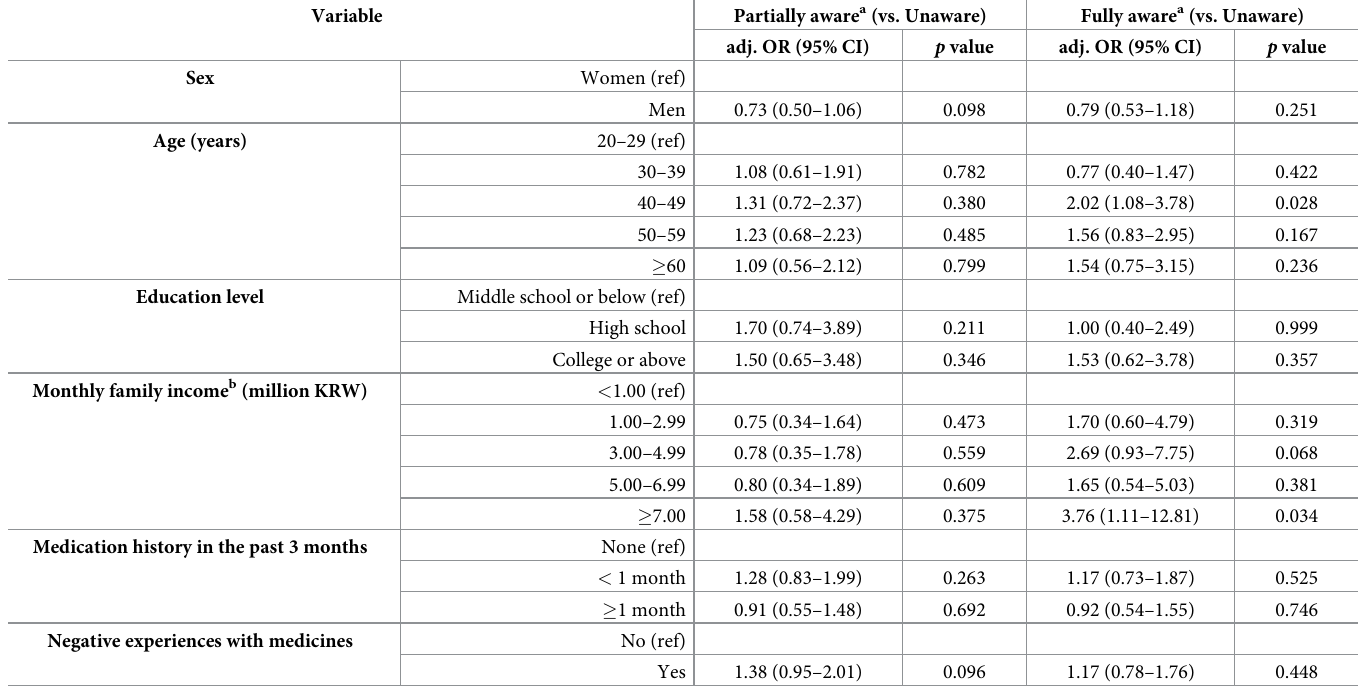
Table 3. Multinomial multivariate logistic regression analysis results for factors that are associated with public awareness of personalized medicine in Korea. Variable Partially aware a (vs. Unaware) Fully aware a (vs.